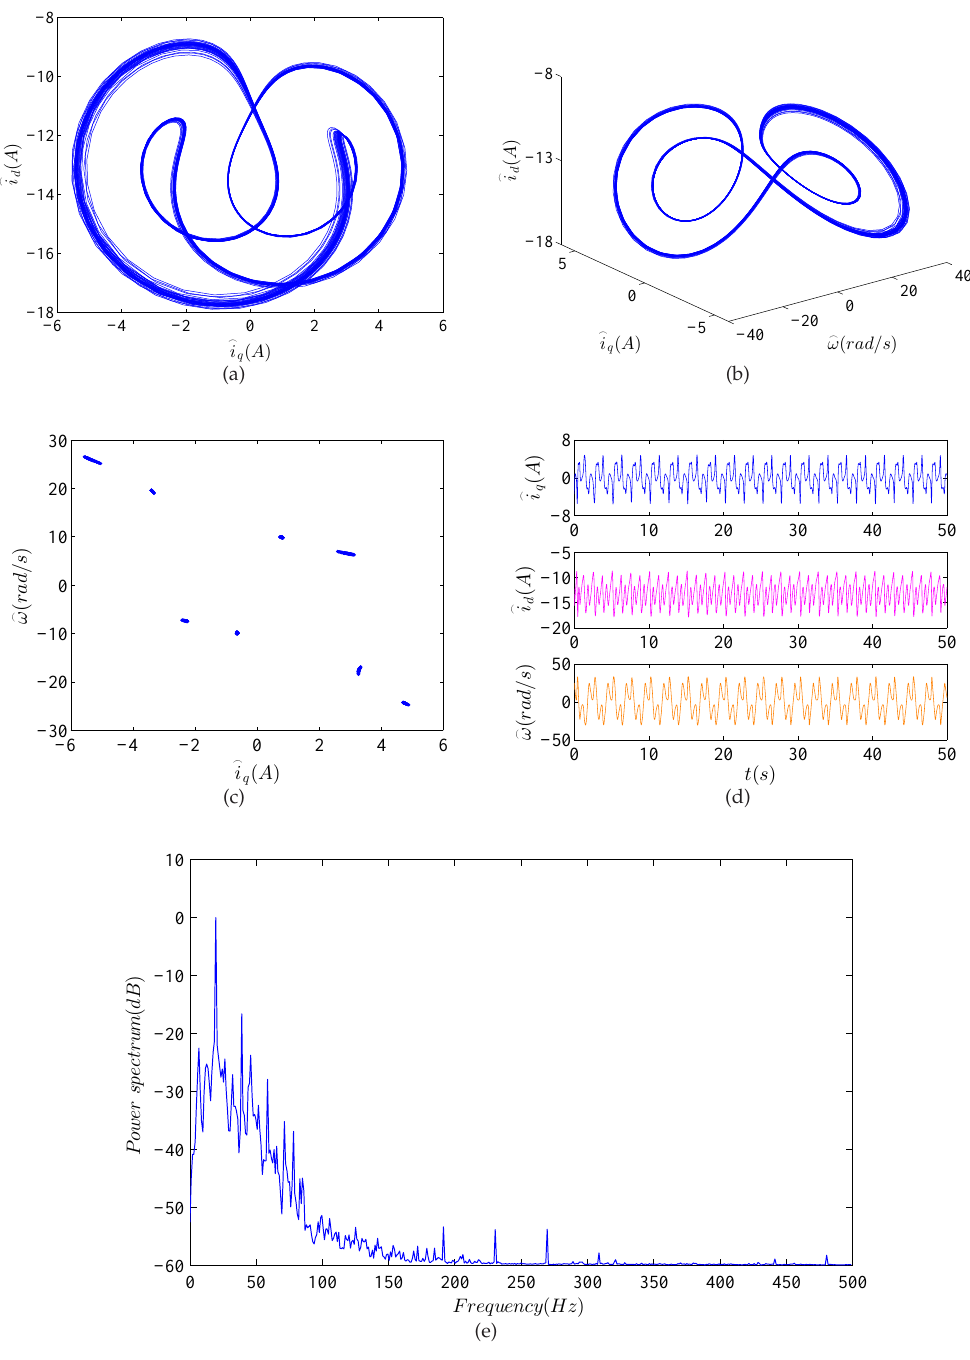
Figure 6. Numerical analysis of nonlinear dynamic behavior with ψ f = 13.44: ( a ) Phase orbit with ⌢ ⌢ i q − i d ; ( b ) Phase orbit with ⌢ ω −